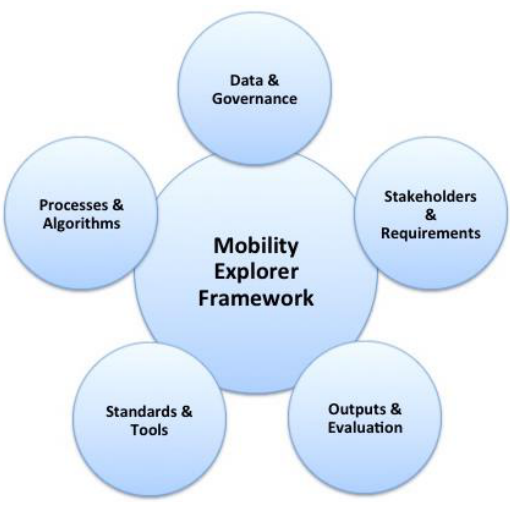
Figure 1. The Mobility Explorer framework elements.